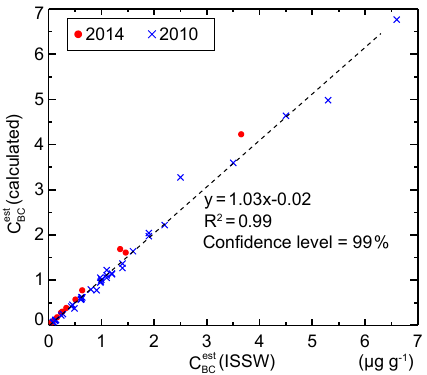
Figure 4. The spatial distribution of C est (b) average snow in 2014 across northeastern China.